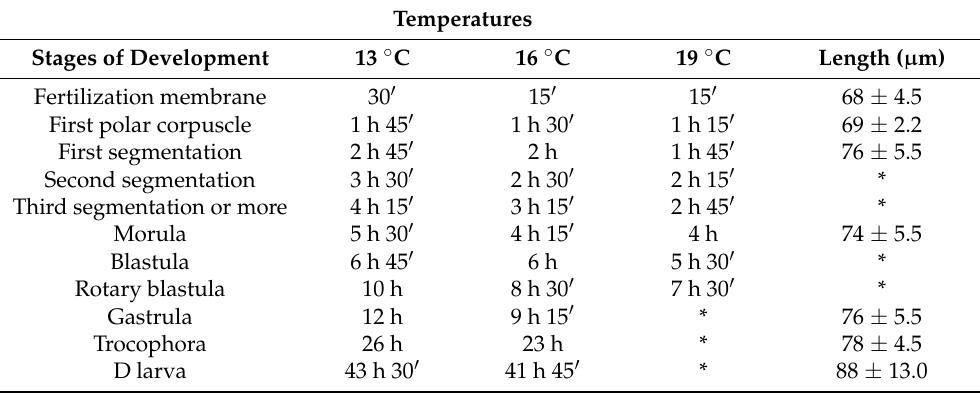
Table 1. Time of developmental stages at different experimental temperatures (13 ◦ C, 16 ◦ C and 19 ◦ C) from fertilized oocytes of the surf clam Mesodesma donacium